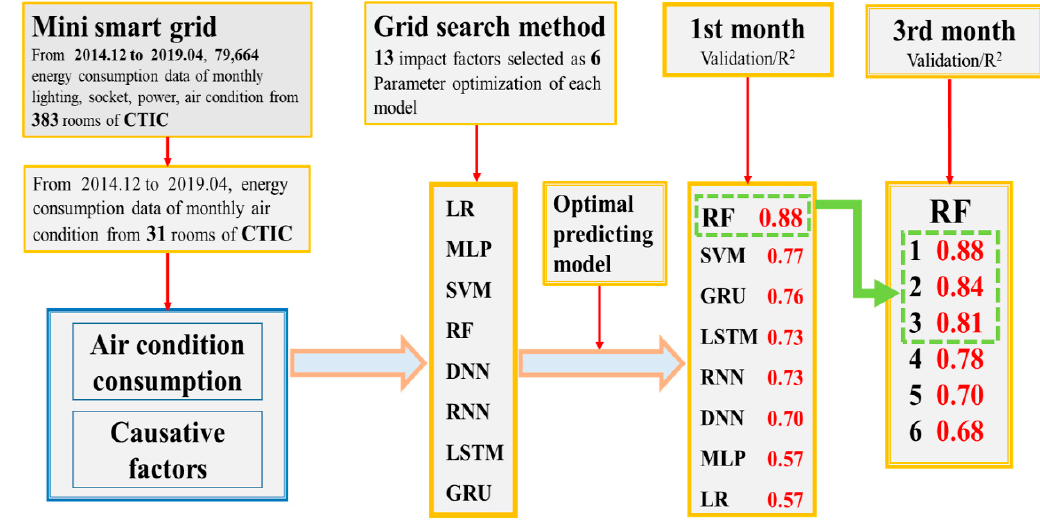
Figure 10. Summary of procedures for 3-month-ahead predictions.